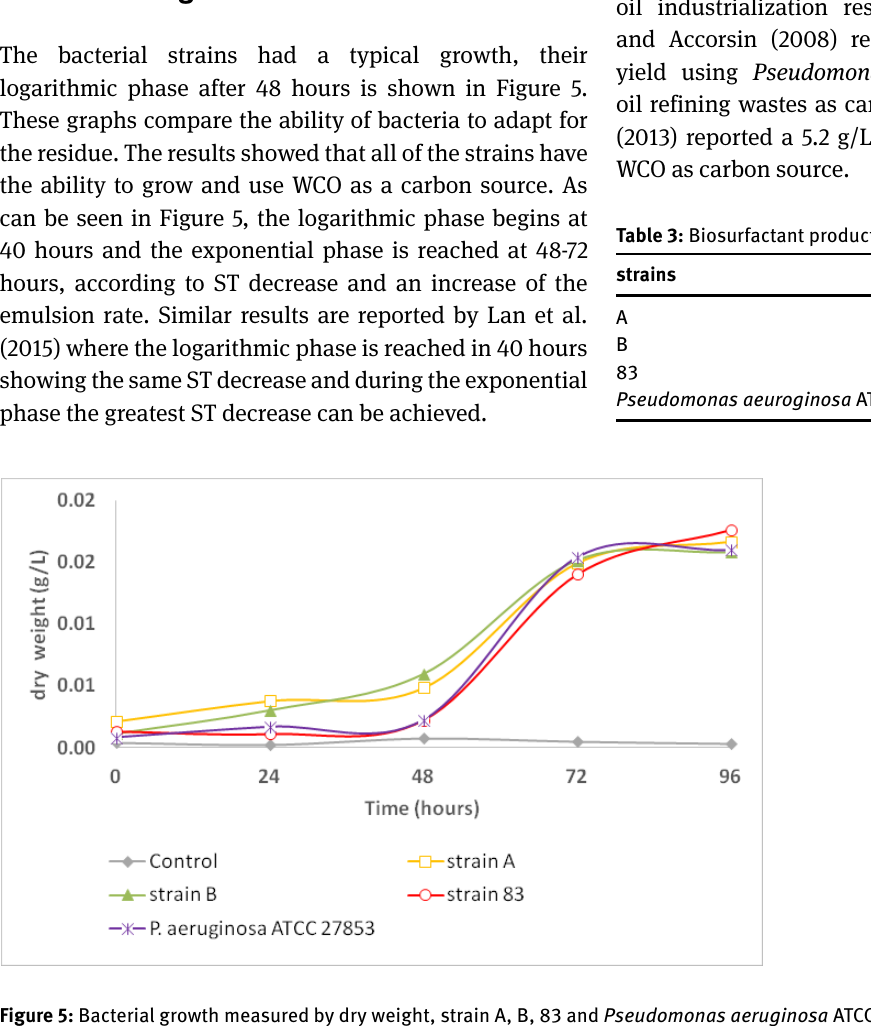
Figure 5: Bacterial growth measured by dry weight, strain A, B, 83 and Pseudomonas aeruginosa ATCC 27853 (positive